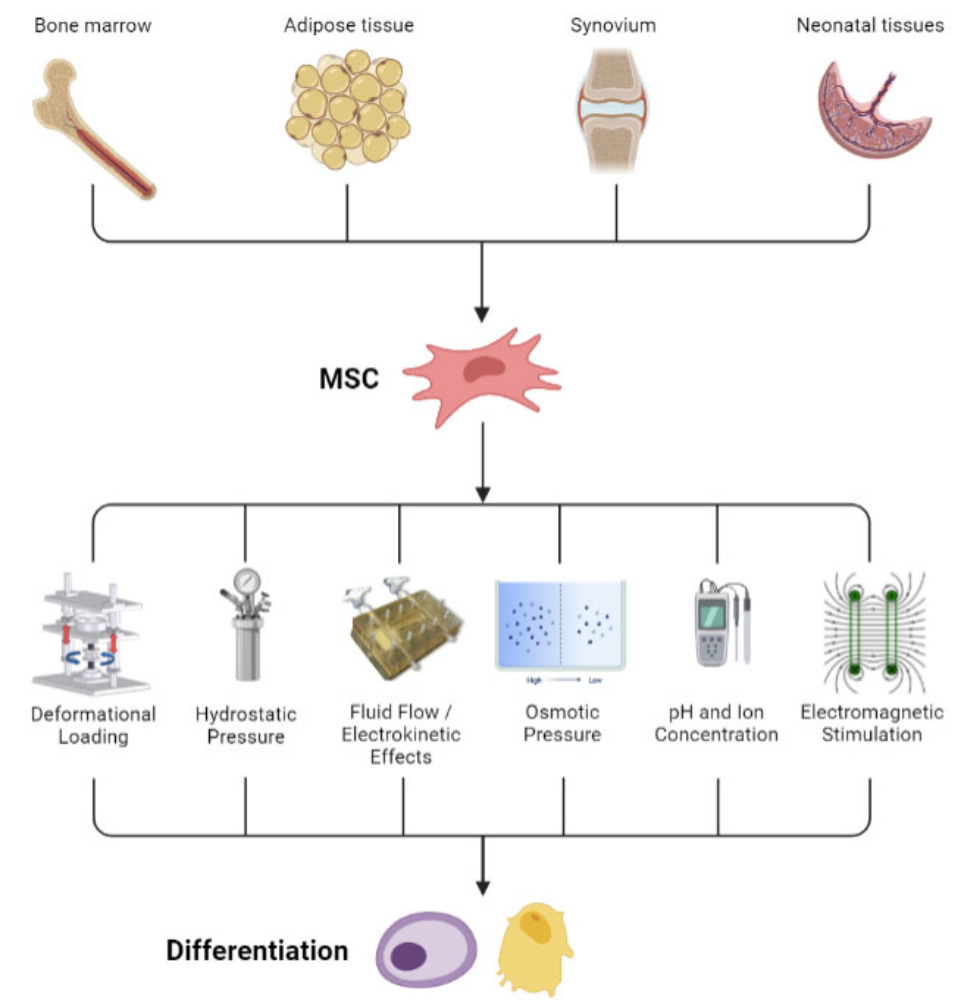
Figure 2. Representation of the harvest of MSCs from multiple tissue sources and biophysical stimulation of the cells to induce differentiation.